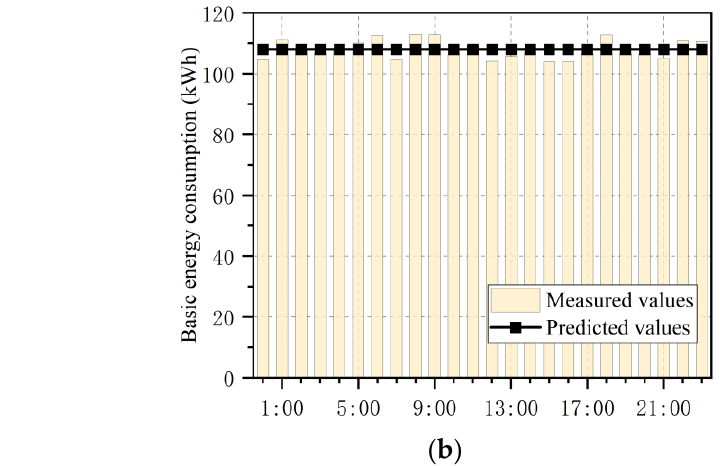
Figure 22. ( a ) Comparison of the predicted and measured results of the basic energy consumption of Case Building A, ( b ) comparison of the predicted and measured results of the basic energy consumption of Case Building B.